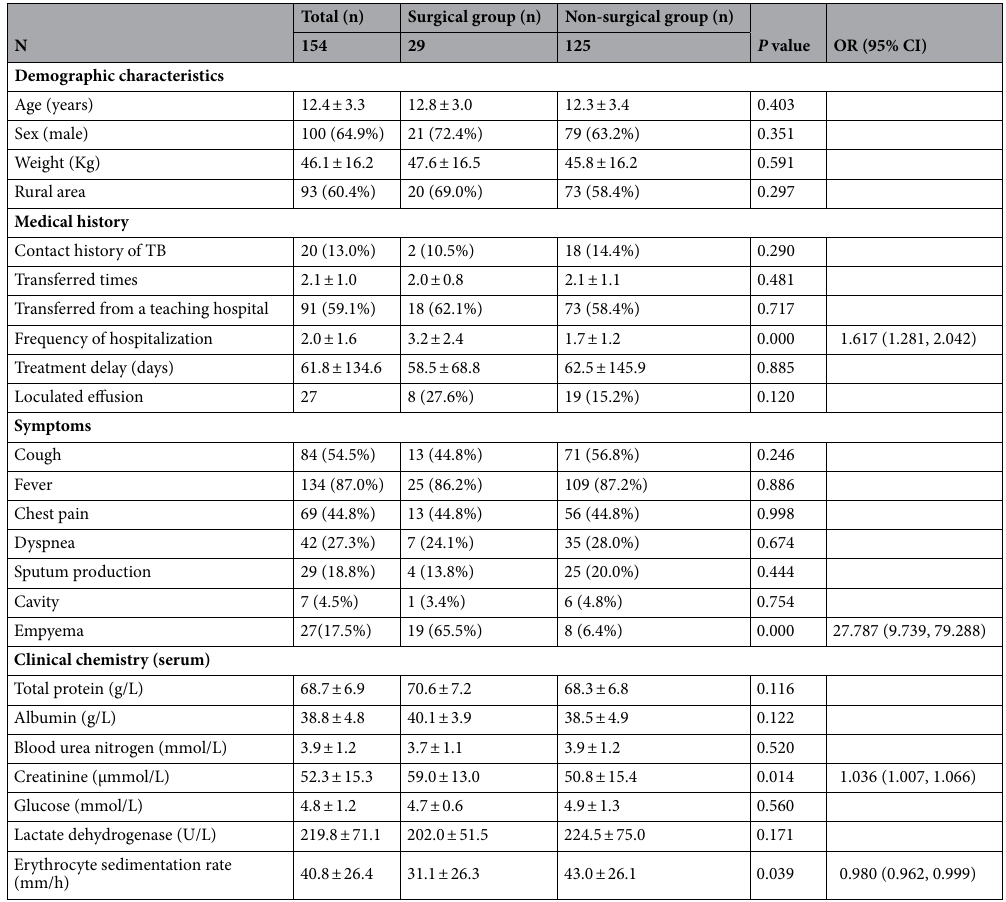
Table 1. Univariate analysis of the demographic data associated with surgical intervention in childhood pleural TB. TB tuberculosis, OR odds ratio, CI confidence interval.